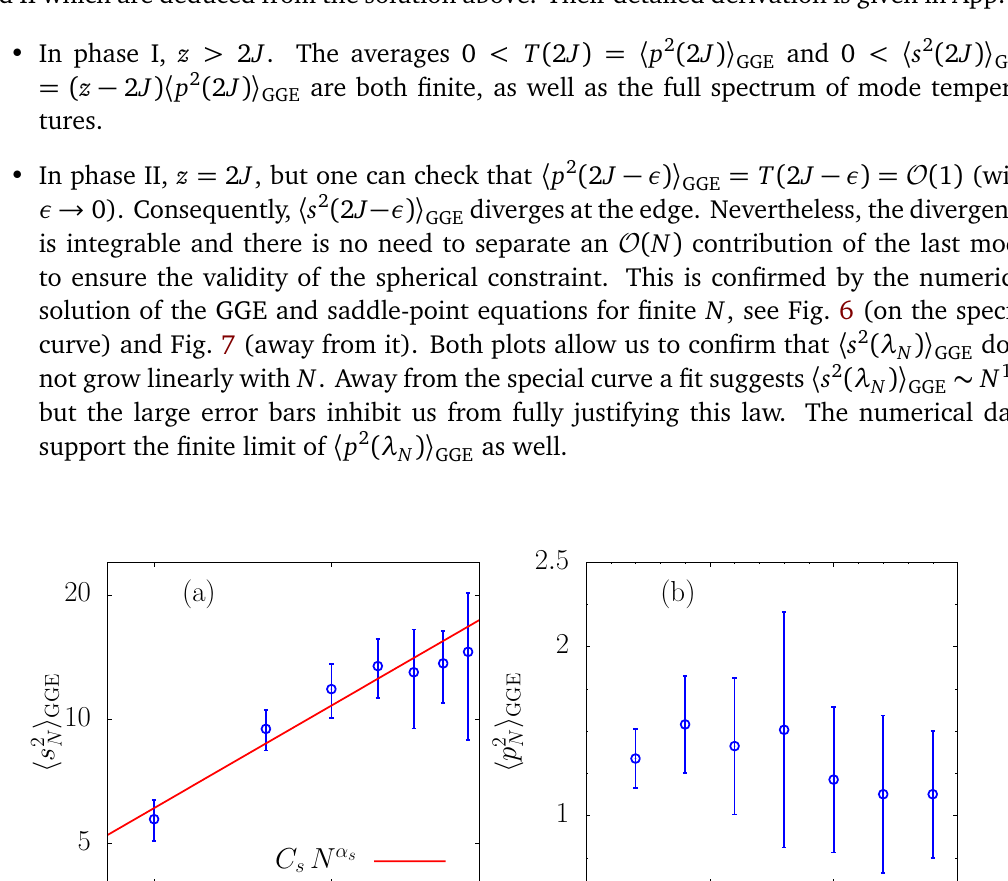
= 1.5 J and J = 1.7 J 0 0 = 1.28, α = 0.52 (b) 〈 p 2 s s